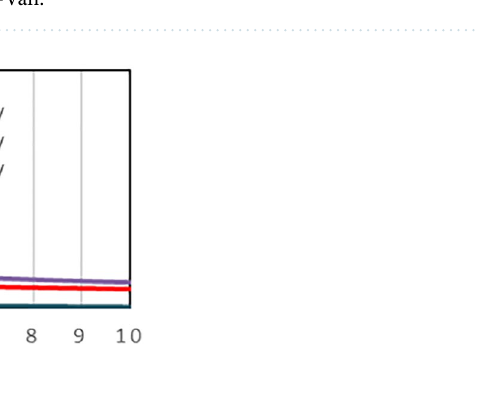
Figure 2. EDS spectrum of (a) TON, (b ) TON-Van.